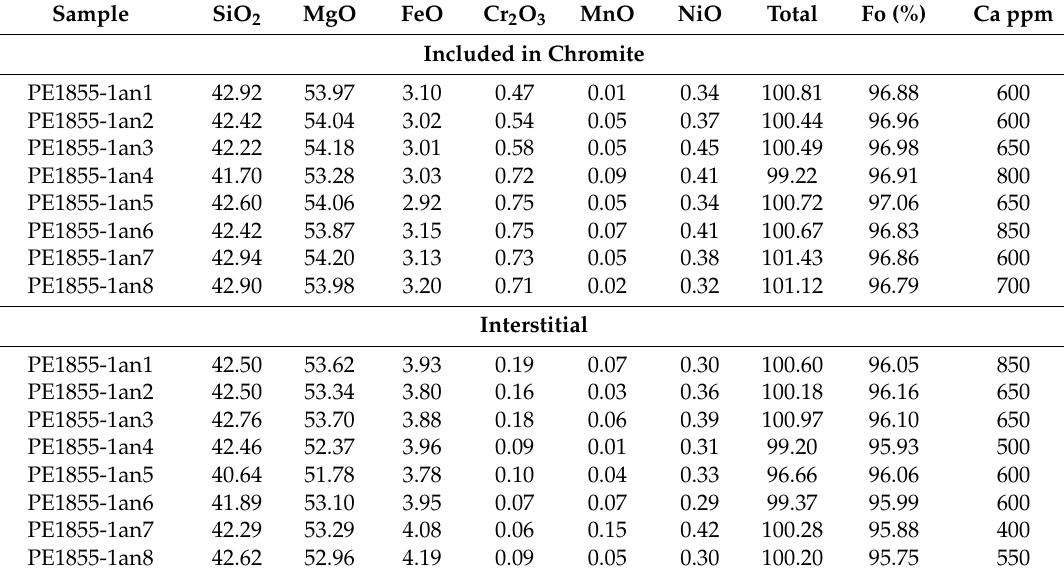
Table A2. Representative electron microprobe analyses (wt %) of olivine from chromitites of Alapaevsk.